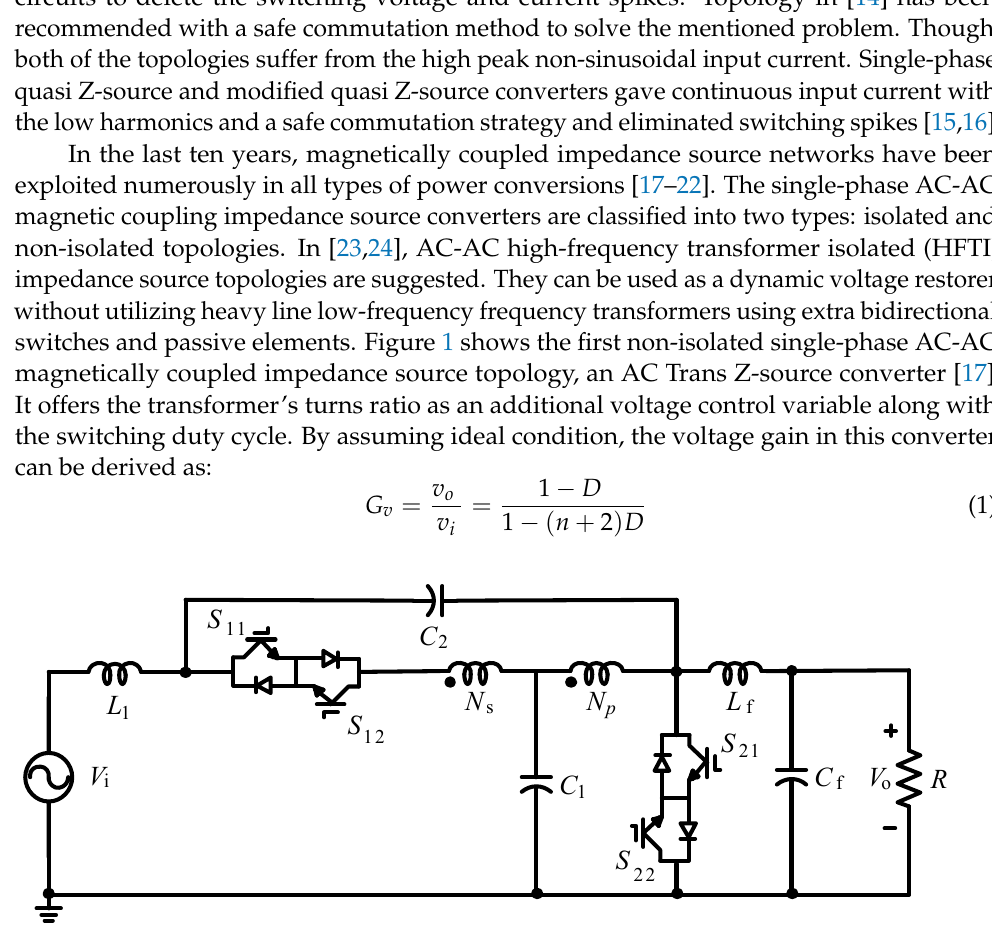
Figure 1. Schematic of the single-phase AC-AC Trans Z-source converter [17]. A modified single-phase trans-Z-source AC-AC topology with no inductor in the output filter is introduced in [25] to meet reduced low-frequency fluctuations and a better power density. However, it applies more bidirectional switches than the existing single- phase Z-source AC-AC converters. In [26,27], passive components at the output filter are eliminated, which results in cost and volume reduction. Nonetheless, this elimination brings current and voltage ripple at the output waveforms. To minimize the transformer’s size and turns number, a single-phase AC Γ -source was in [18], which is illustrated in Figure 2. The main disadvantage of this converter is its discontinuous input current, which has a high peak value and high THD. By considering the ideal state, the voltage gain can be calculated